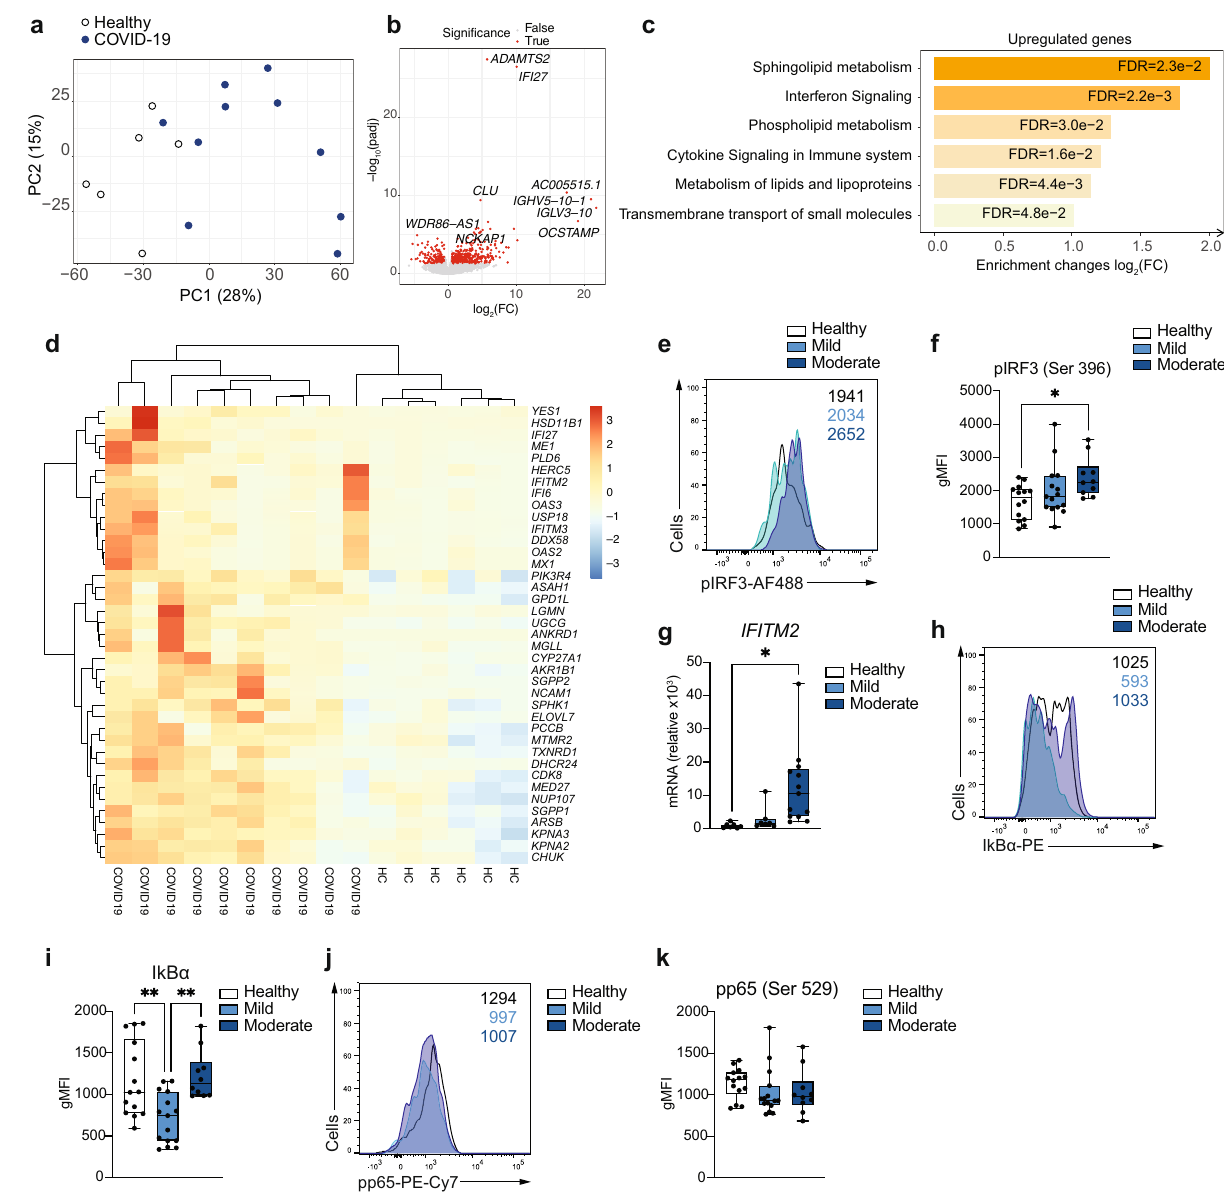
Fig. 2 | Gene expression signature of COVID-19 monocytes ex vivo. a Principal component analysis of the gene expression data computed from all genes from ex vivo healthy individual (white dots) and moderate COVID-19 (blue dots) monocyte samples. The variance explained by each component is stated in brackets. b Volcano plot of differentially expressed genes for ex vivo COVID-19 vs. healthy monocytes. Genes with fold change ≥ 1.5 and FDR<0.05 are shown in red. c Bar plots depict signi fi cantly enriched (FDR<0.05) pathways from Reactome for COVID-19 vs. healthy individual monocytes using upregulated genes ( ≥ 1.5 fold increase, FDR<0.05). Fold enrichment plotted as log 2 (FC) and bars labelled with the adjusted p -value. d Heatmapof signi fi cantlyupregulated genes in COVID-19 vs. healthy monocyte that are members of the pathways in c . Gene expression values arescaledbyrow,withrelativelyhighexpressionindicatedinredandrelativelylow expression in blue. Both rows and columns are clustered using Euclidean distance and Ward ’ s method. Representative example ( e ) and summary gMFI ( f ) of